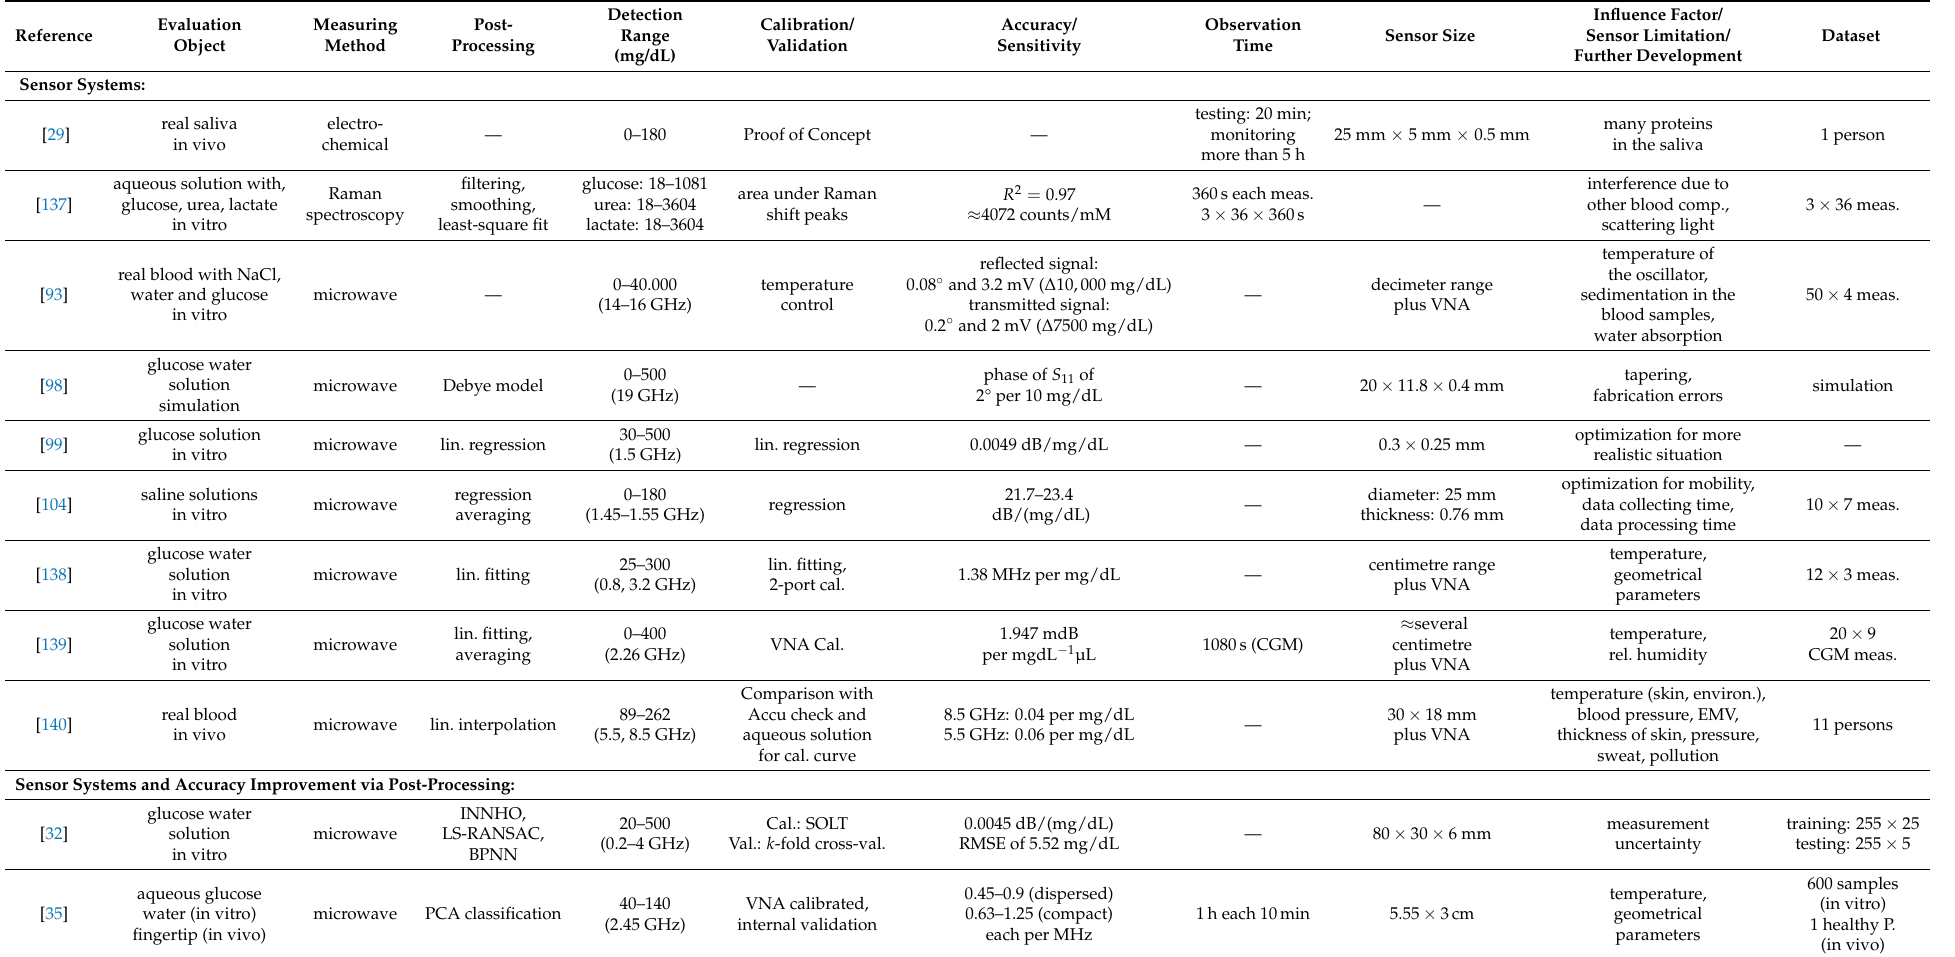
Table 10. Review and comparison of different sensor systems with and without AI-based